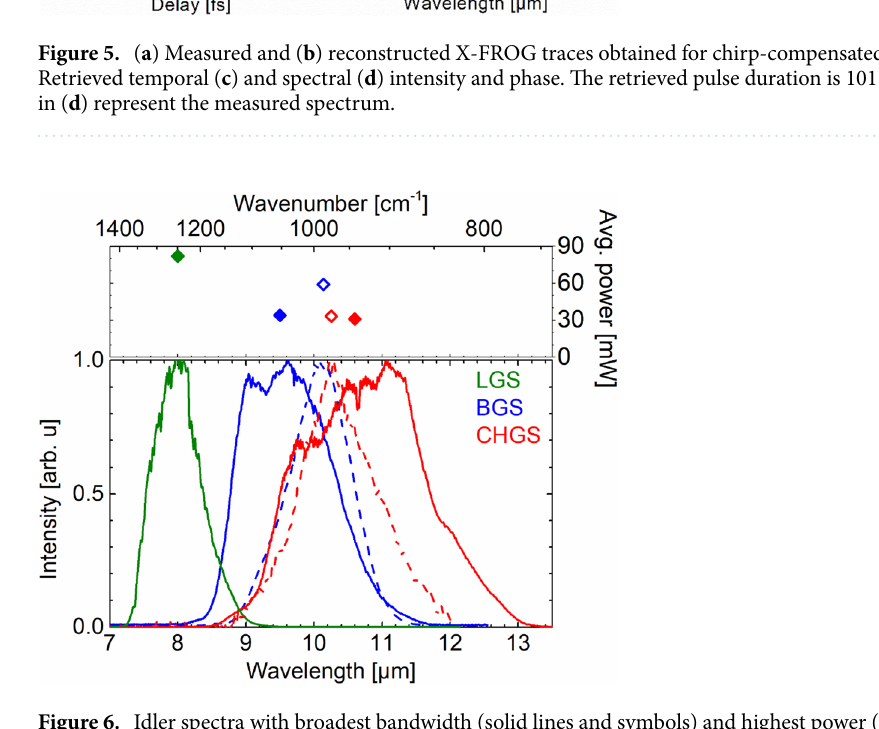
Figure 6. Idler spectra with broadest bandwidth (solid lines and symbols) and highest power (dashed lines and open symbols) and the corresponding average power delivered by a single-stage OPA based on an 8-mm-long LGS (ref. 17 ), an 8.3-mm-long BGS (ref. 17 ), and a 2-mm-long Cd 0.65 Hg 0.35 Ga 2 S 4 (this